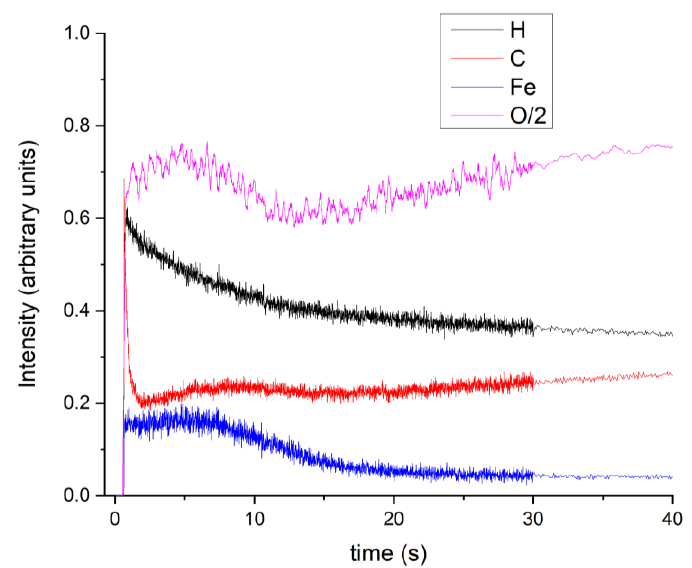
Figure 8. GDOES depth profile of the DIO-NPs layers.